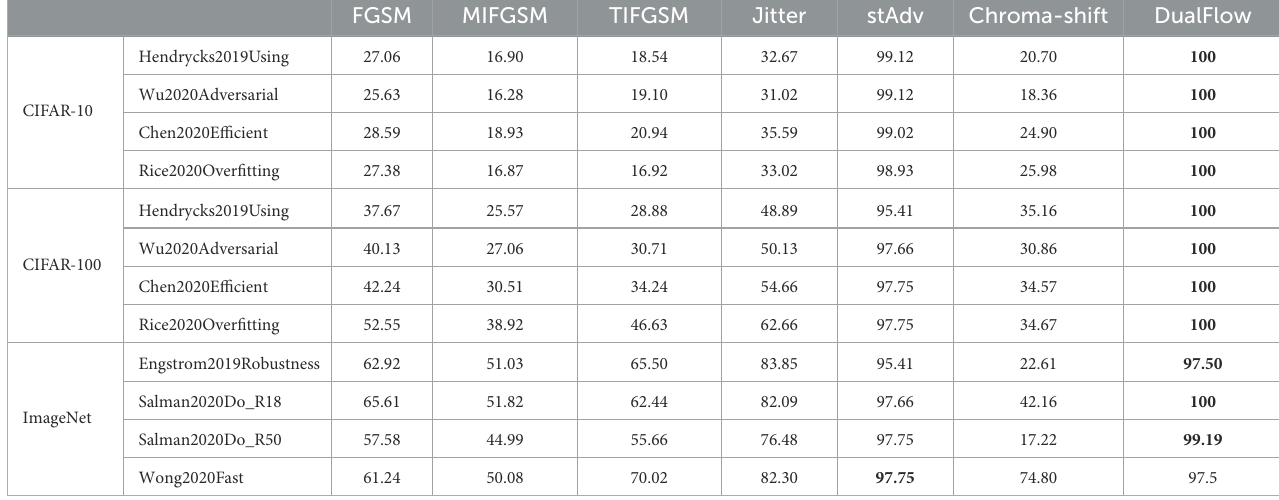
TABLE 5 Experimental results on the attack success rate of un-targeted attack on CIFAR-10, CIFAR-100 and ImageNet dataset to robust models.